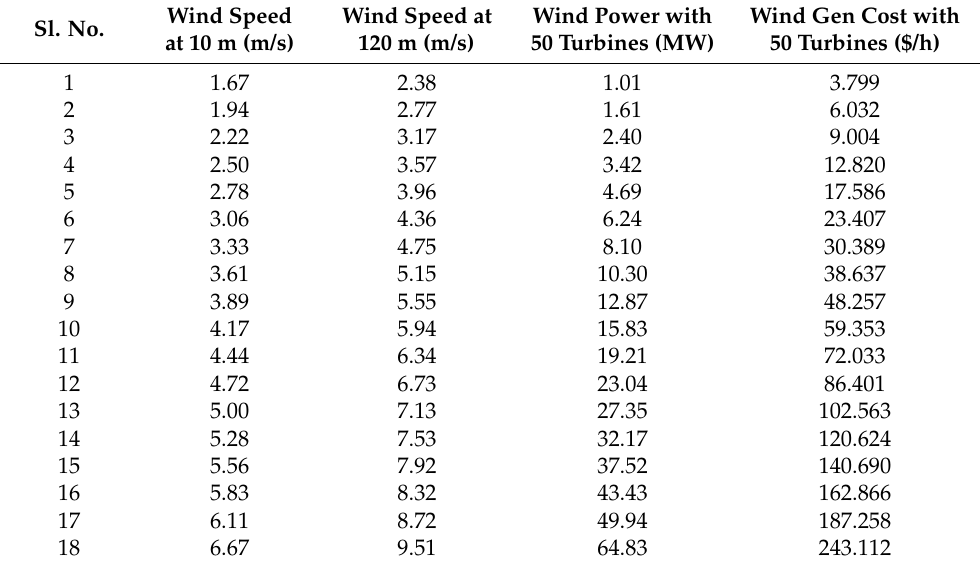
Table 2. Wind speed and wind power investment cost. Sl.